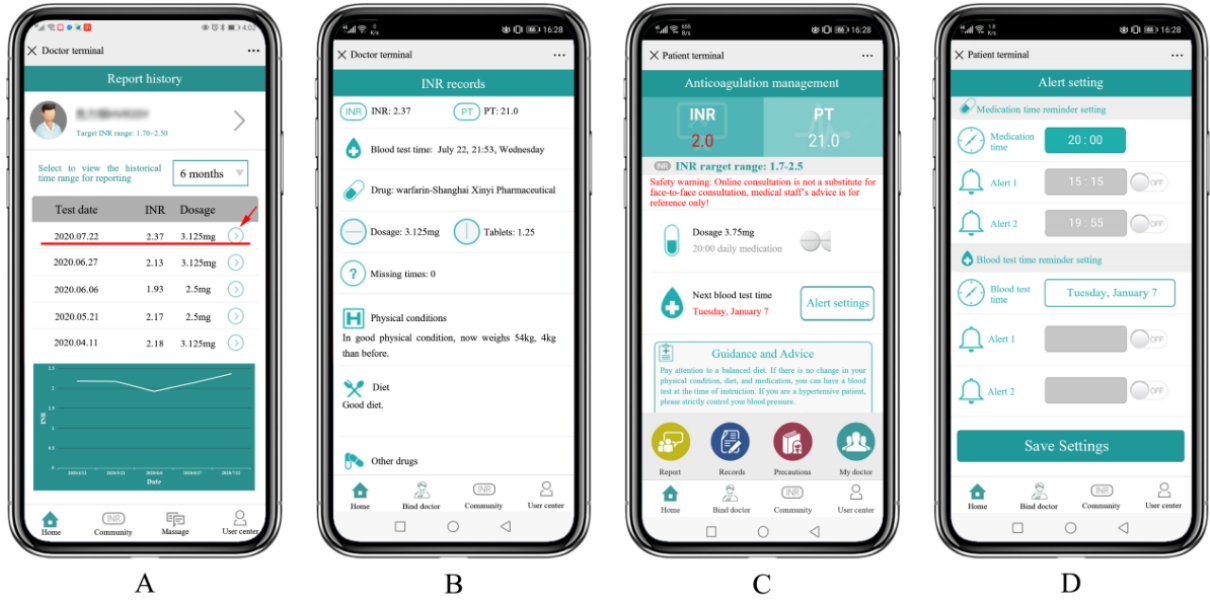
Figure 1. Alfalfa